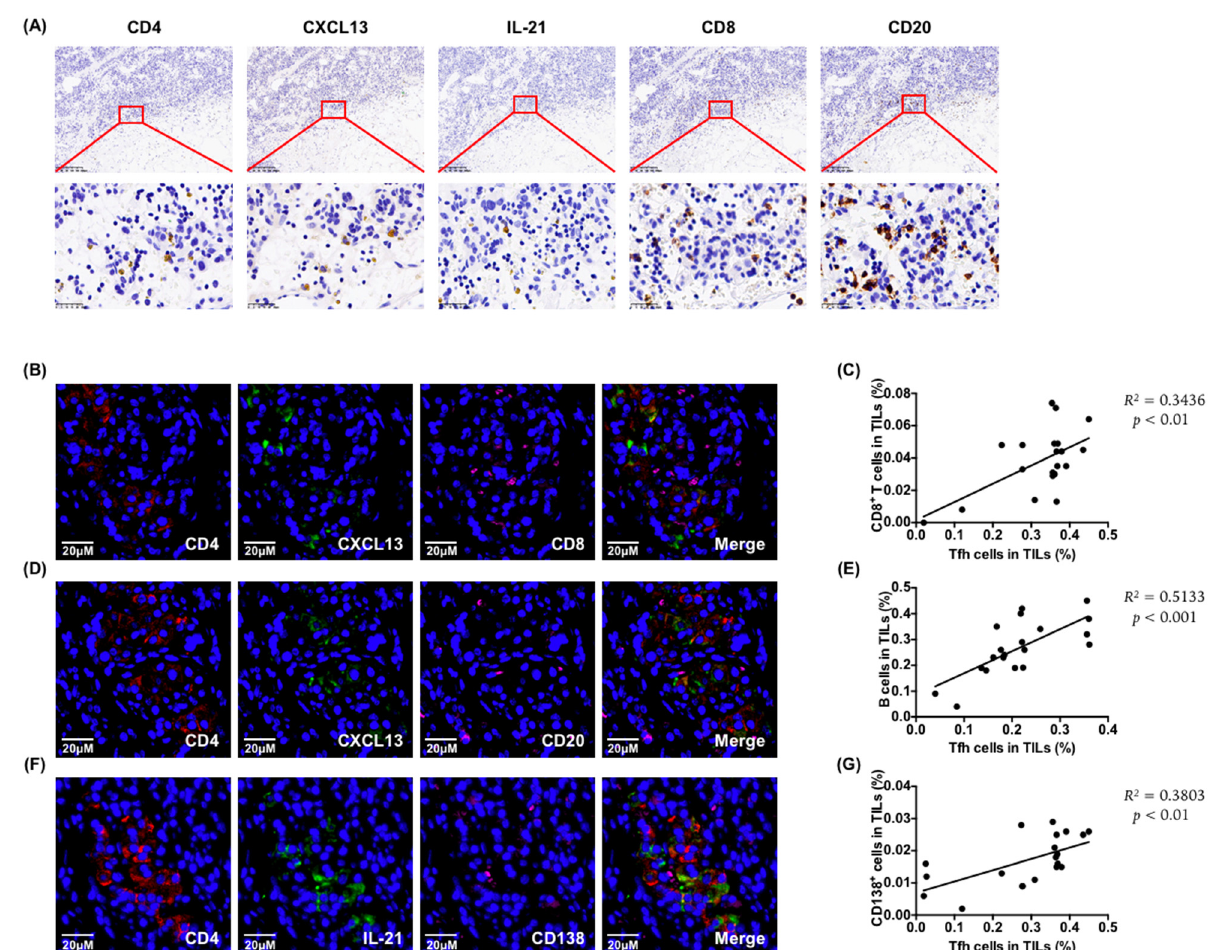
Figure 2. Tumor-infiltrating Tfh cells were related to CD8 + T cells and B cells infiltration. ( A ) Representative images of immunohistochemistry for CD4 + , CXCL13 + , IL-21 + , CD8 + , and CD20 + cells of continuous slices of tumor tissue from patients with PDAC. Scale bars: 200 µm or 25 µm. ( B ) Representative images of the immunofluorescence of the co-localization of functional tumor-infiltrating Tfh cells (CD4 + CXCL13 + ) with CD8 + T cells. Scale bars: 20 µm. ( C ) Correlation between functional tumor-infiltrating Tfh cells (CD4 + CXCL13 + ) with CD8 + T cells ( n = 20). ( D ) Representative images of immunofluorescence of the co-localization of functional tumor-infiltrating Tfh cells (CD4 + CXCL13 + ) with CD20 + B cells. Scale bars: 20 µm. ( E ) Correlation between functional tumor-infiltrating Tfh cells (CD4 + CXCL13 + ) with CD20 + B cells ( n = 20). ( F ) Representative images of the immunofluorescence of the co-localization of functional tumor-infiltrating Tfh cells (CD4 + IL-21 + ) with CD138 + plasma cells. Scale bars: 20 µm. ( G ) Correlation between functional tumor-infiltrating Tfh cells (CD4 + IL-21 + ) and CD138 + plasma cells ( n = 20).